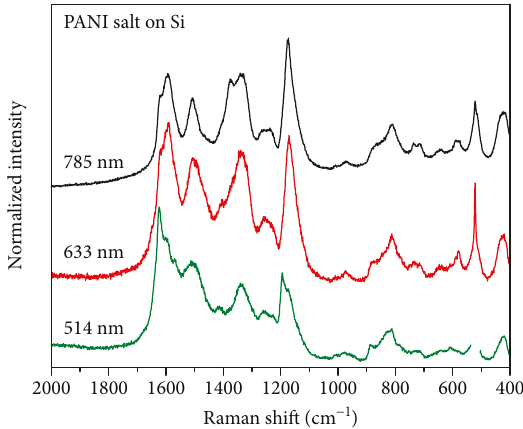
Figure 1: Raman spectra of intact PANI hydrochloride fi lms on silicon support obtained with 514, 633, and 785nm laser